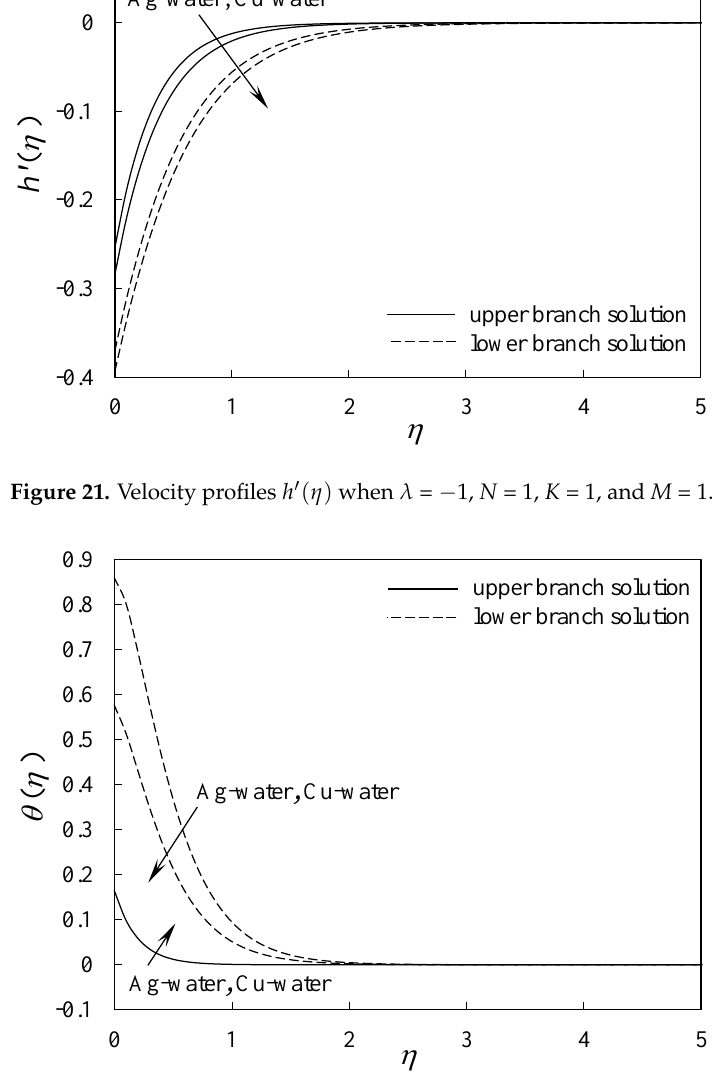
Figure 22. Temperature profiles